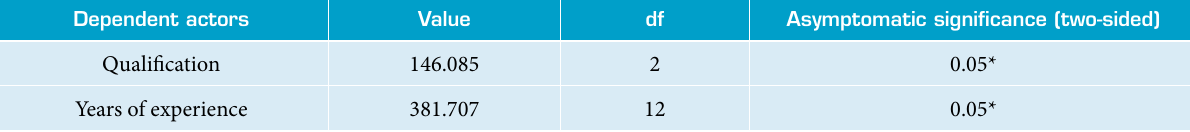
Table 3. Association between qualification and years of experience of the dental professionals with the familiarity of terms Dependent actors Value df Asymptomatic significance (two-sided) Qualification 146.085 2 0.05* Years of experience 381.707 12